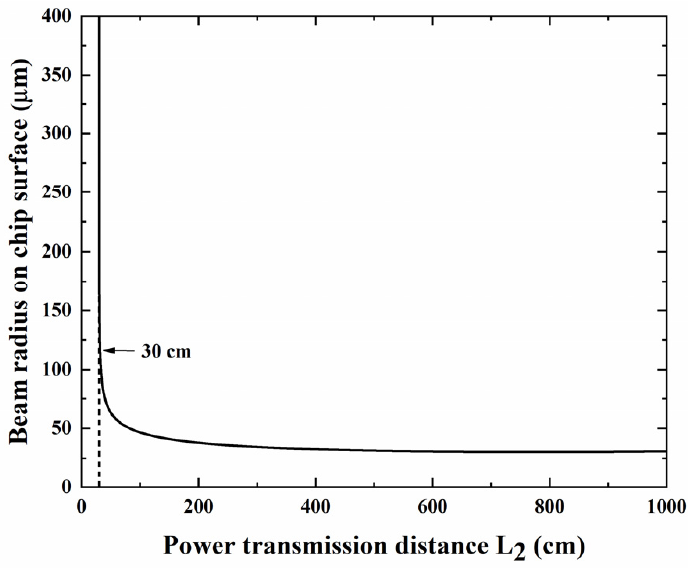
Figure 3. Beam radius of the cavity on the chip surface varying with the cavity length L 2 . Figure 4 shows the simulation results obtained after adjusting the position of the optical device in the laser cavity. As shown in Figure 4a, the stable operating region of the laser cavity after the parameter adjustment has changed significantly. Compared with the original stable cavity region, the laser cavity can also function stably at a transmission distance L 2 of 5 m. When L 2 is in the range of 0.3 to 2 m, the stable working range of the laser cavity is widened and the distance L 1 between the chip and M 1 ranges from 15 to 16 cm. This relatively wide stability range indicates that the difficulty associated with laser cavity debugging is reduced. Next, the variation of the beam radius of the chip surface with the transmission distance L 2 is next simulated in this stable working range. As shown in Figure 4b, when the transmission distance is within 0.3 to 2 m, the beam radius of the intracavity beam on the chip surface remains above 100 µ m. Beyond the stable working area, the beam radius on the chip surface becomes extremely large, which indicates the leakage of the laser in the cavity. A cavity base film with this spot size is sufficient to support a large pump spot and achieve a high power